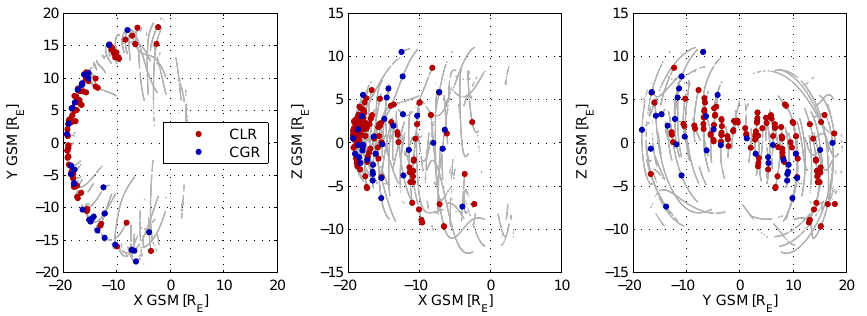
Fig. 6. The localization of CLRs (red) and CGRs (blue) in GSM xyz space. The grey lines indicates the Cluster sampling in the plasma sheet during the summer and fall of 2001. The right plot shows that CLRs generally prefer locations deeper into the plasma sheet and closer to the neutral